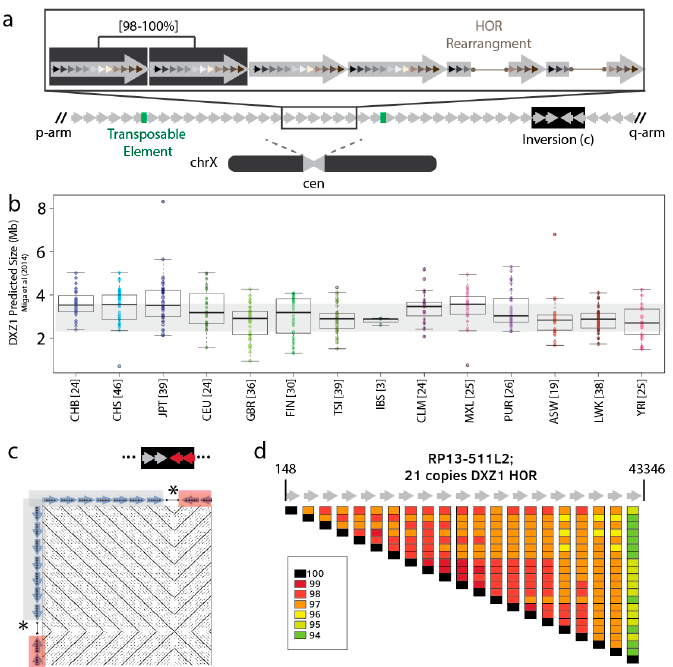
Figure 2. Intra-array satellite sequence variation. (a) All normal human centromeric regions contain at least one alpha satellite array, shown in grey, which is tandemly organized in a head-to-tail orientation with occasionally transposable element interruptions (green) and shifts in directionality (black box). The fundamental alpha satellite repeat unit, or ~171 bp monomer, is shown in a variation of shaded colors to illustrate the heterogeneity of the sequencing identity. Multi-monomer repeat units, or ‘higher-order repeats (HORs), are shown by the larger grey arrows that encompass the collection of smaller repeats. In contrast to the individual monomers, these repeats are shown to be identical, or near-identical (98–100%). In addition to single nucleotide differences between the HORs, larger rearrangements (shown as a deletion of five monomers) are observed to occur and expand and contract within the array. (b) Satellite array length predictions on the X chromosome (DXZ1) [7], grey shading marks the previously observed PFGE Southern length range [25]. (c) Inversion detected using error-corrected PacBio reads [68]. (d) RP13-511L2 is an X-specific BAC that represents the transition from core alpha satellite to the edge of the array. HOR pair-wise repeat identity (muscle alignment [72]) showing increased divergence approaching the chromosome arm (43,346 bp), as typically observed at the edge of the array.